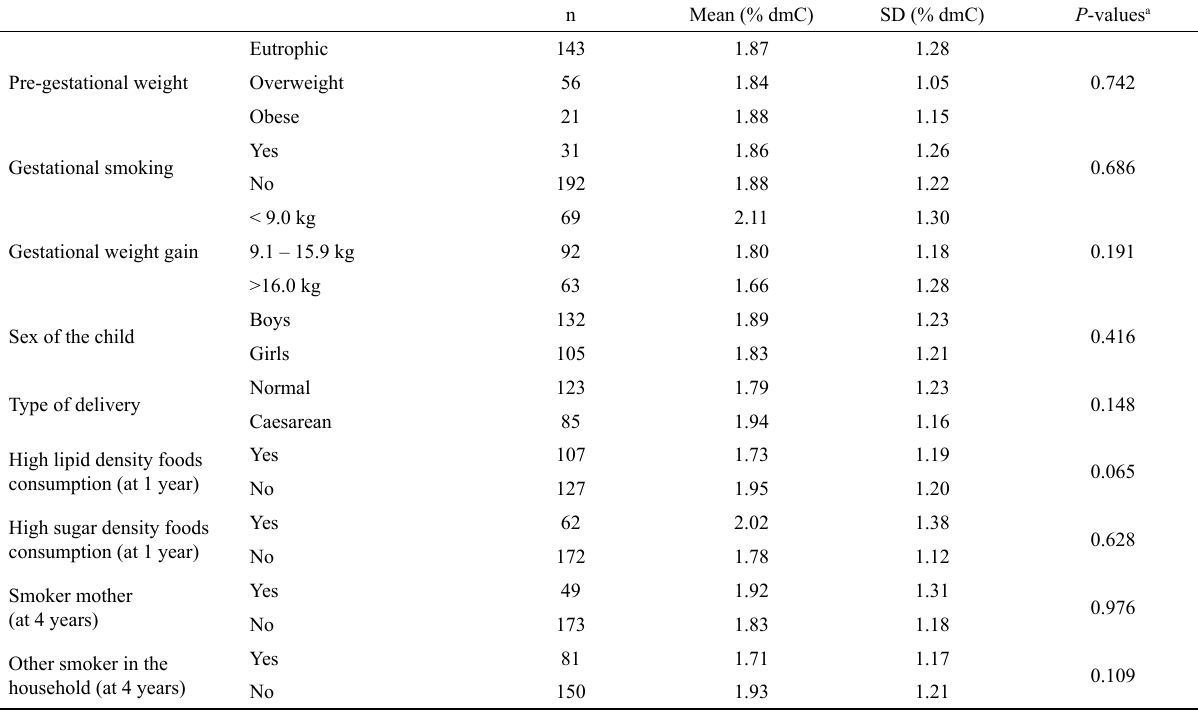
Table 3 – Comparison of methylation levels according to the environmental factors to which children were exposed.